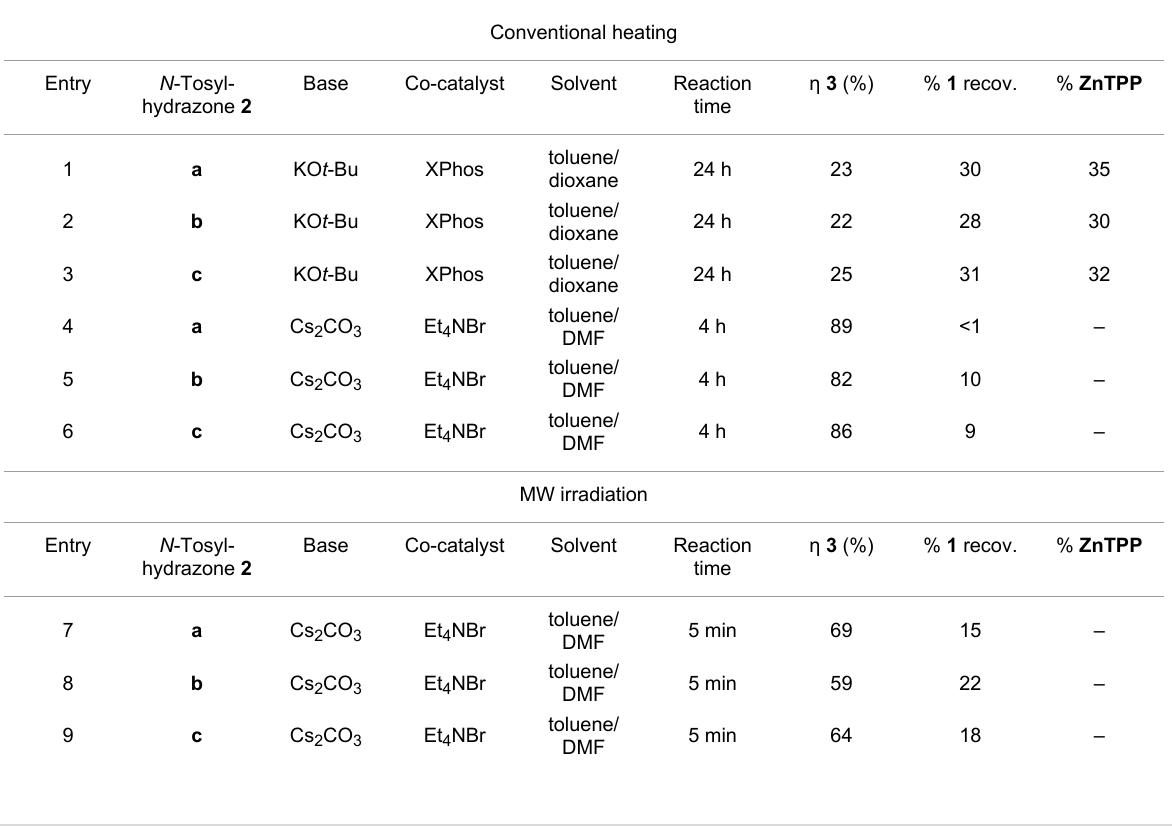
Table 1: Results obtained in the palladium-catalyzed cross-coupling reactions between β -brominated porphyrin 1 with N -tosylhydrazones 2a–c